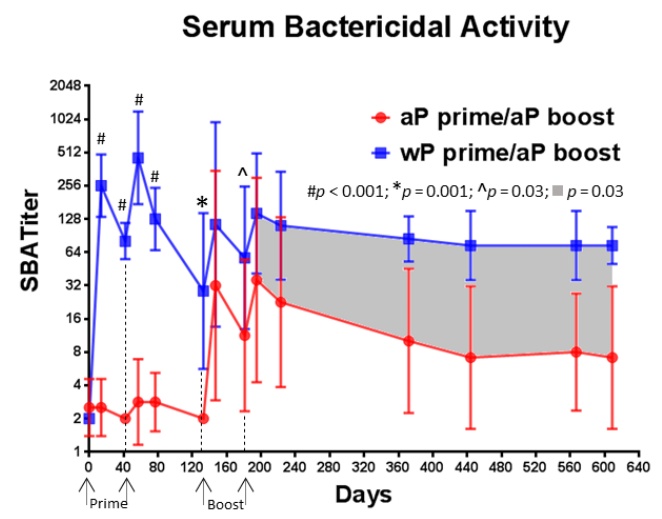
Figure 7. Priming with wP vaccine leads to higher serum bactericidal antibody titers. The serum bactericidal antibody response was measured in a classical killing assay against Bordetella pertussis . The data shown at each time point are the mean values from 6 individual animals and the 95% CI is noted with the corresponding lines. A statistical analysis was performed using two different